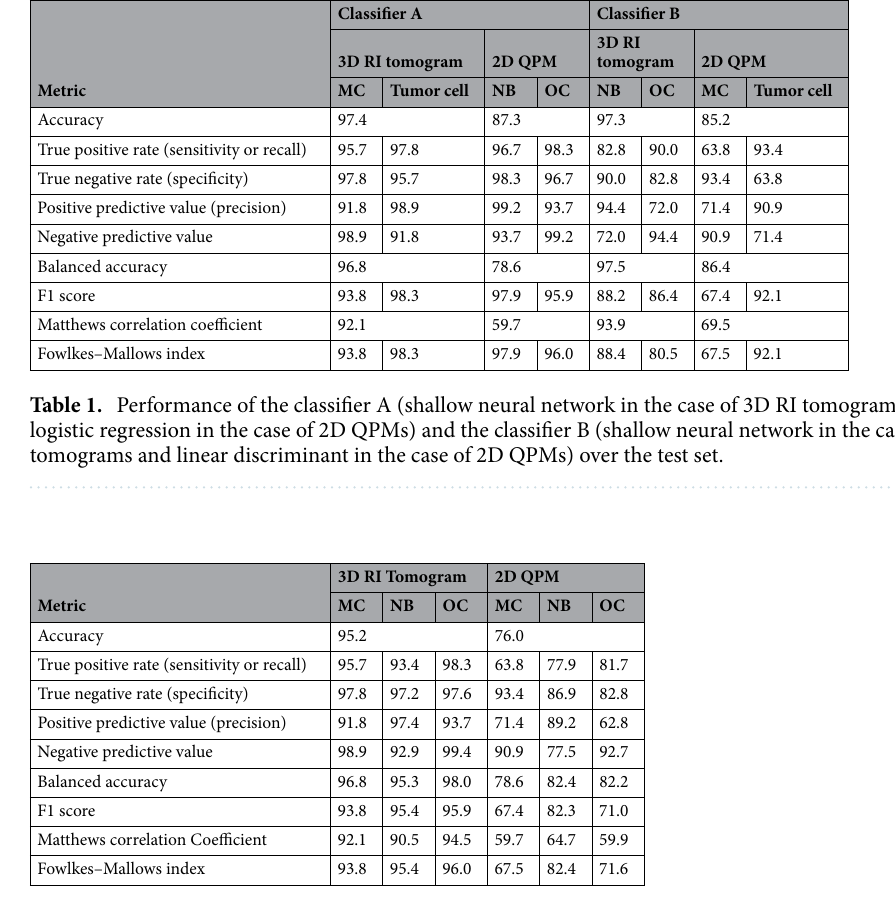
Table 2. Performance of the hierarchical classifier over the test set (shallow neural network + shallow neural network in the case of 3D RI tomograms and logistic regression + linear discriminant in the case of 2D QPMs).